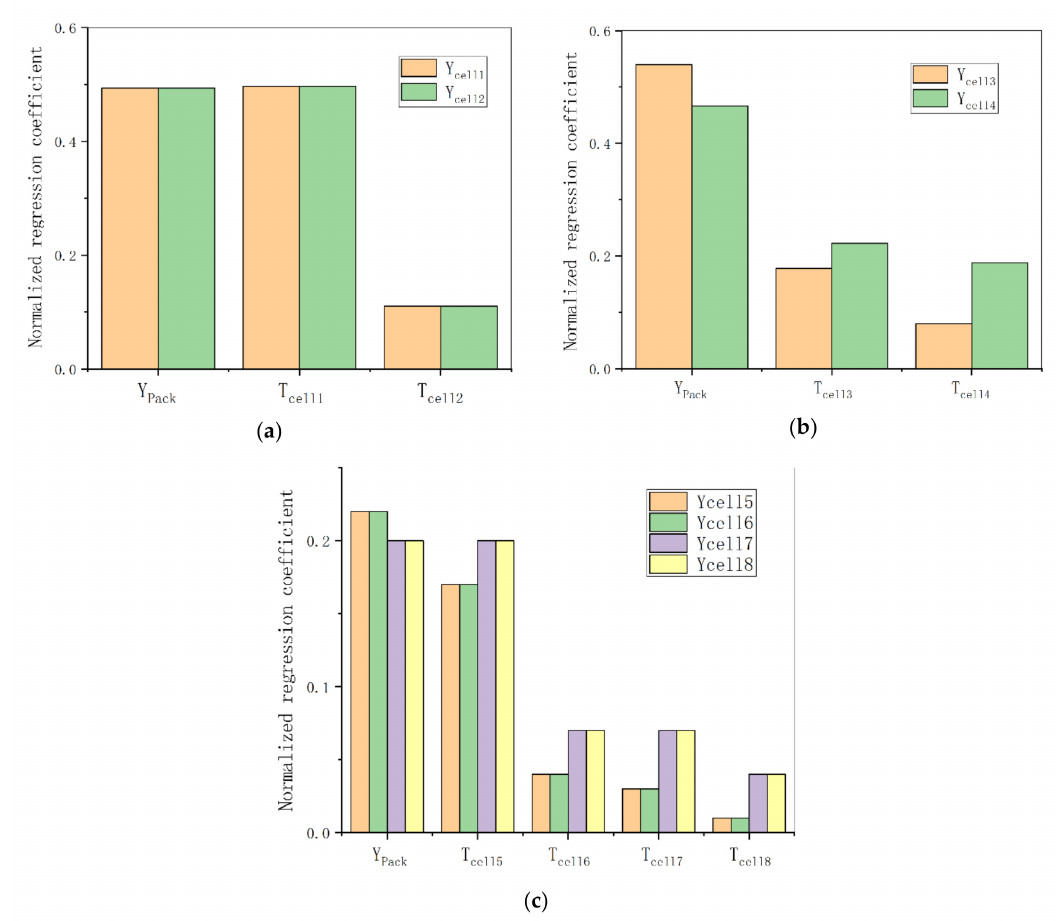
Figure 10. Normalized coe ffi cient histograms: ( a ) Pack A; ( b ) Pack; ( c ) Pack